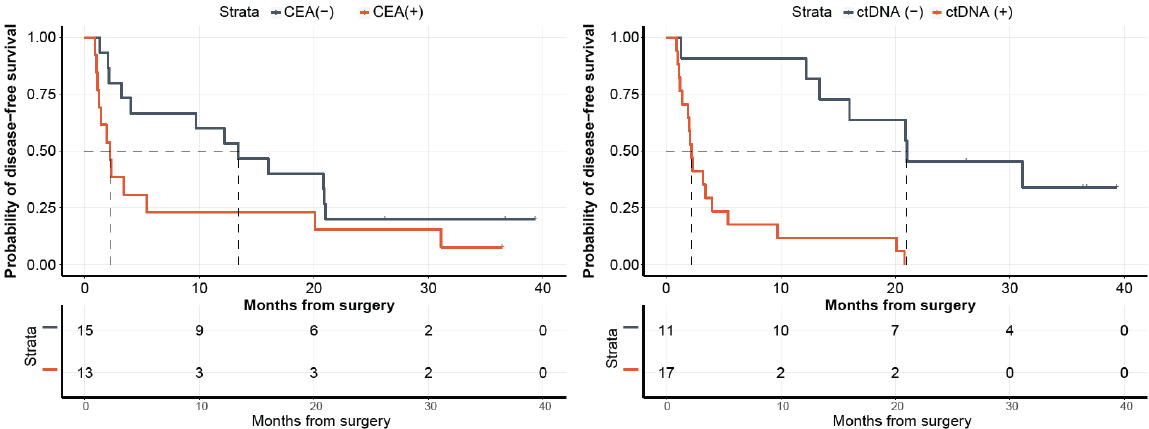
Figure 7. Kaplan–Meier estimates for 28 patients with Carcinoembryonic antigen (CEA) test results and ctDNA monitoring. The population when stratified by CEA result did not show a significant association with DFS (left). In contrast, patients stratified by ctDNA detection (MRD) at the postsurgical time point (T1) did show a significant association with DFS (right; p = 0.0001).